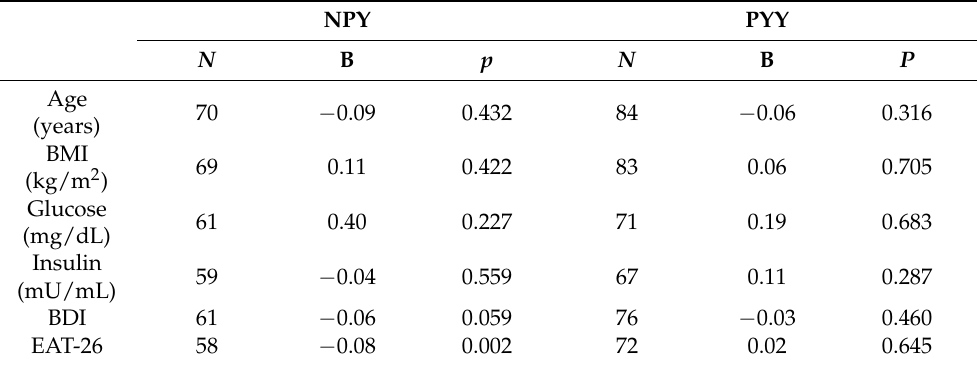
Table 3. Age, BMI, fasting serum glucose and insulin, and psychopathological symptoms measured with the Eating Attitudes Test (EAT-26) and the Beck Depression Inventory (BDI) as the potential confounders of neuropeptide Y (NPY) and peptide YY (PYY) levels in adolescents across the weight spectrum (anorexia nervosa, obesity, and healthy control